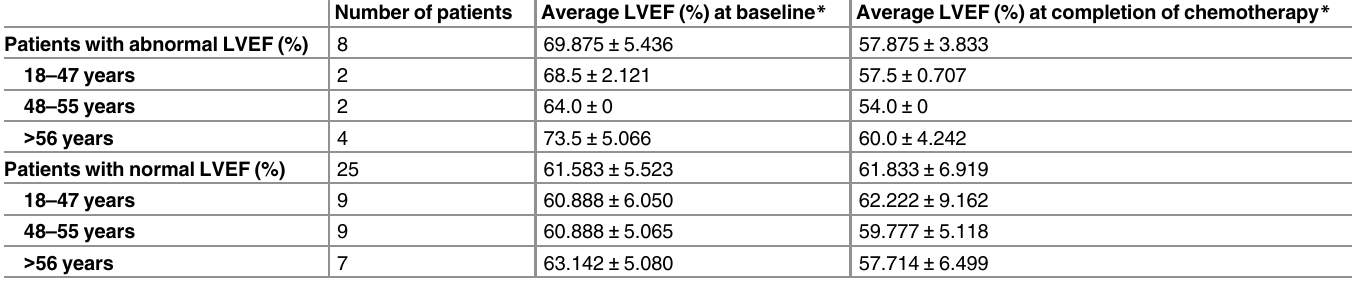
Table 1. Cardiac function of women with breast cancer, treated with DOX-based chemotherapy. MUGA scan was performed before the start of DOX chemotherapy and at its completion.